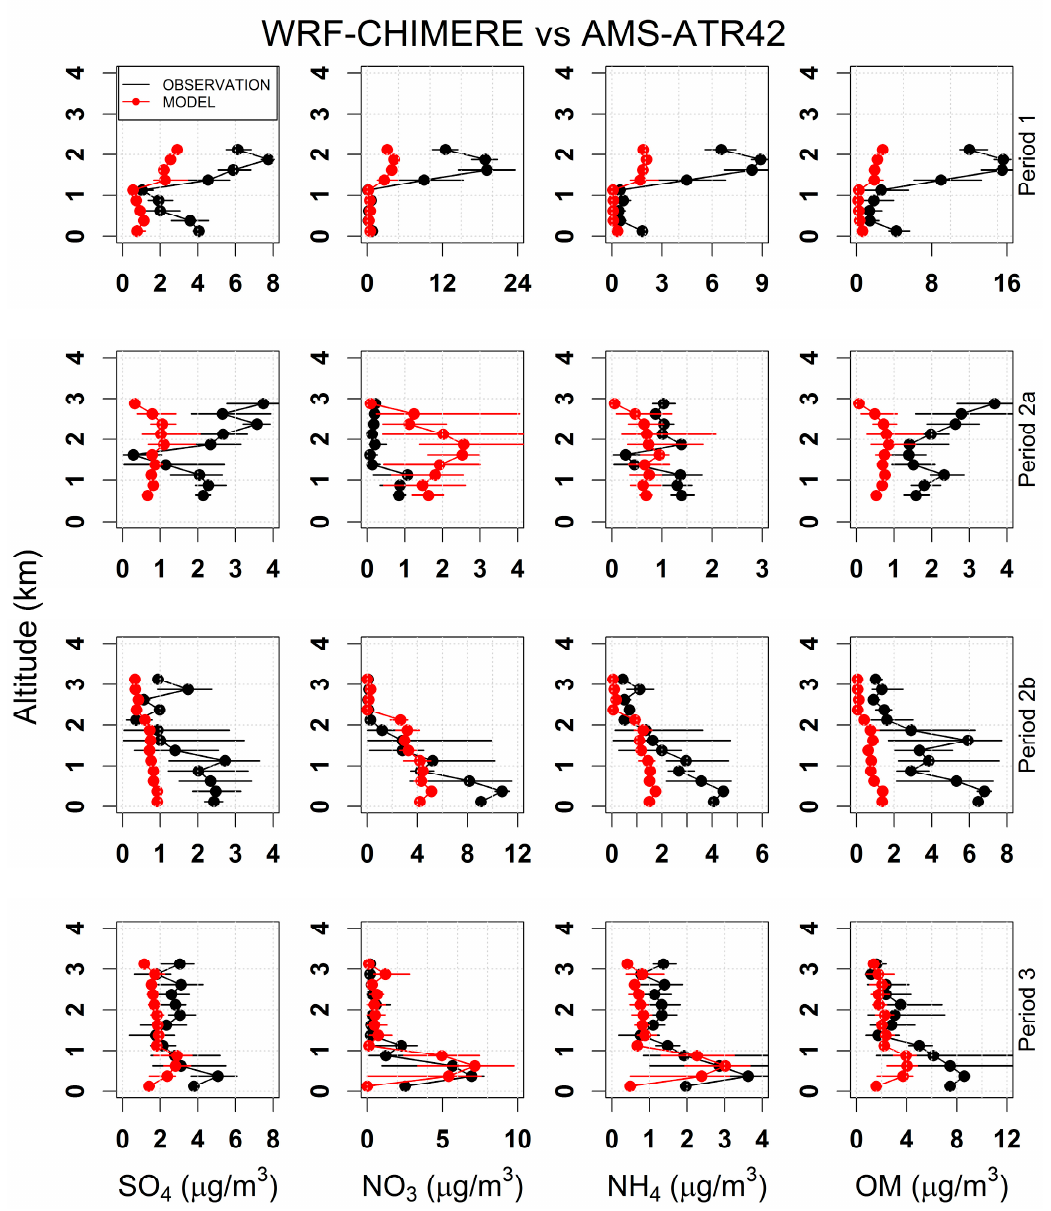
Figure 4. Comparison of AMS measurements aboard of ATR-42 (black) and modelled (red) vertical profiles of trimean (dots) of mass concentration of SO 4 (fist column), NO 3 (second columns), NO 4 (third column), and OM (fourth column), during the period 1 (first row), 2a (second row), 2b (third row), and 3 (fourth row). The black and red bars represent the observed and predicted 25th and 75th percentiles, respectively.